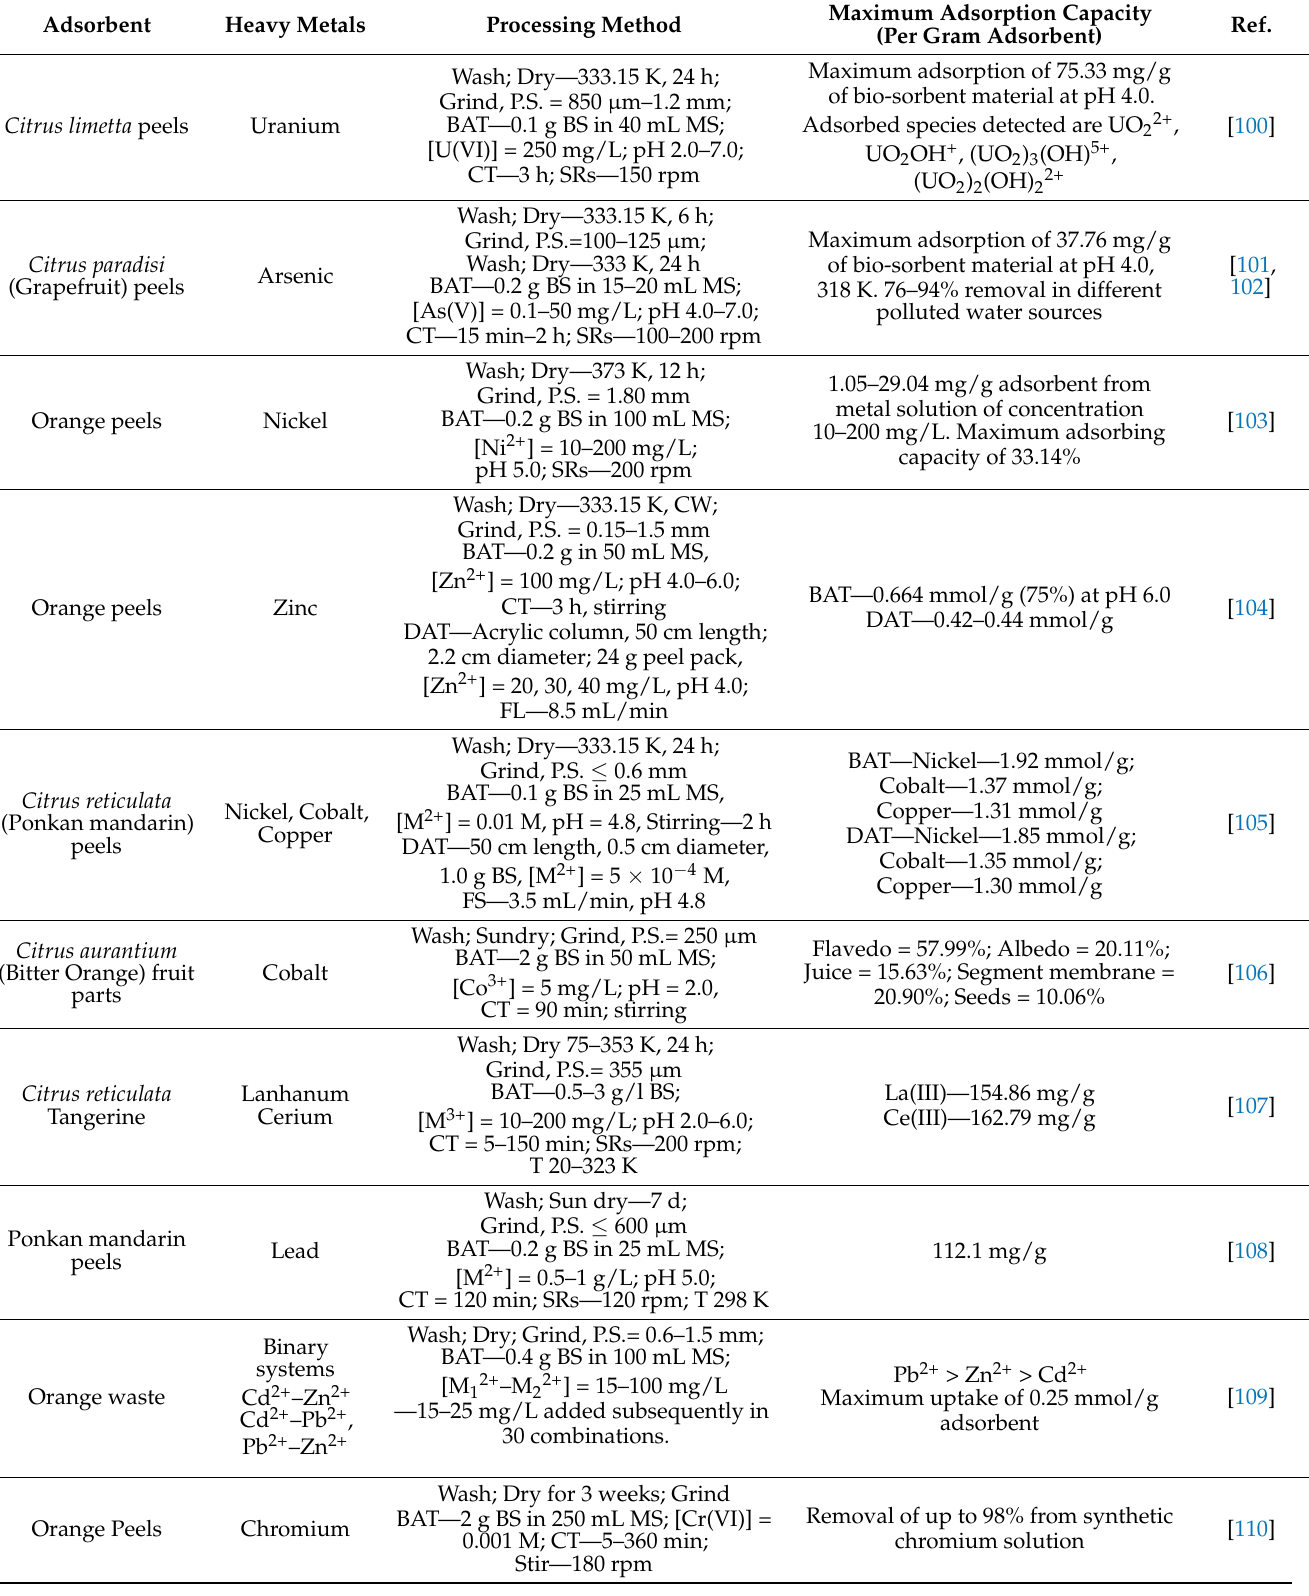
Table 2. Citrus waste-based bio-sorbents for removal of heavy metals from wastewater (BAT: Batch Adsorption Test; DAT: Direct Adsorption Test (Column